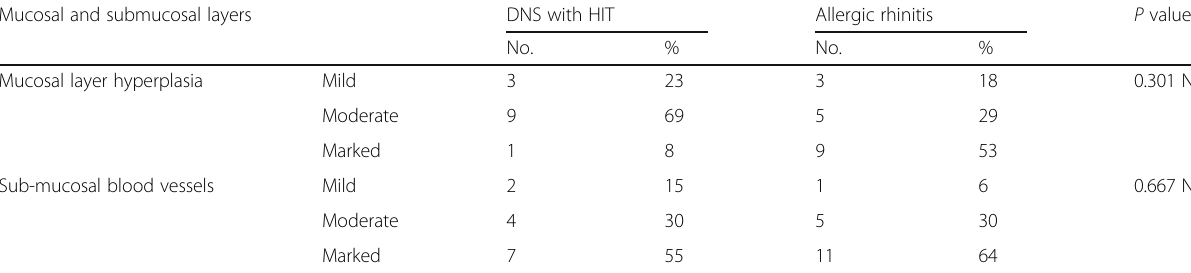
Table 3 Mucosal and submucosal layers of studies specimens Mucosal and submucosal layers DNS with HIT Mucosal layer